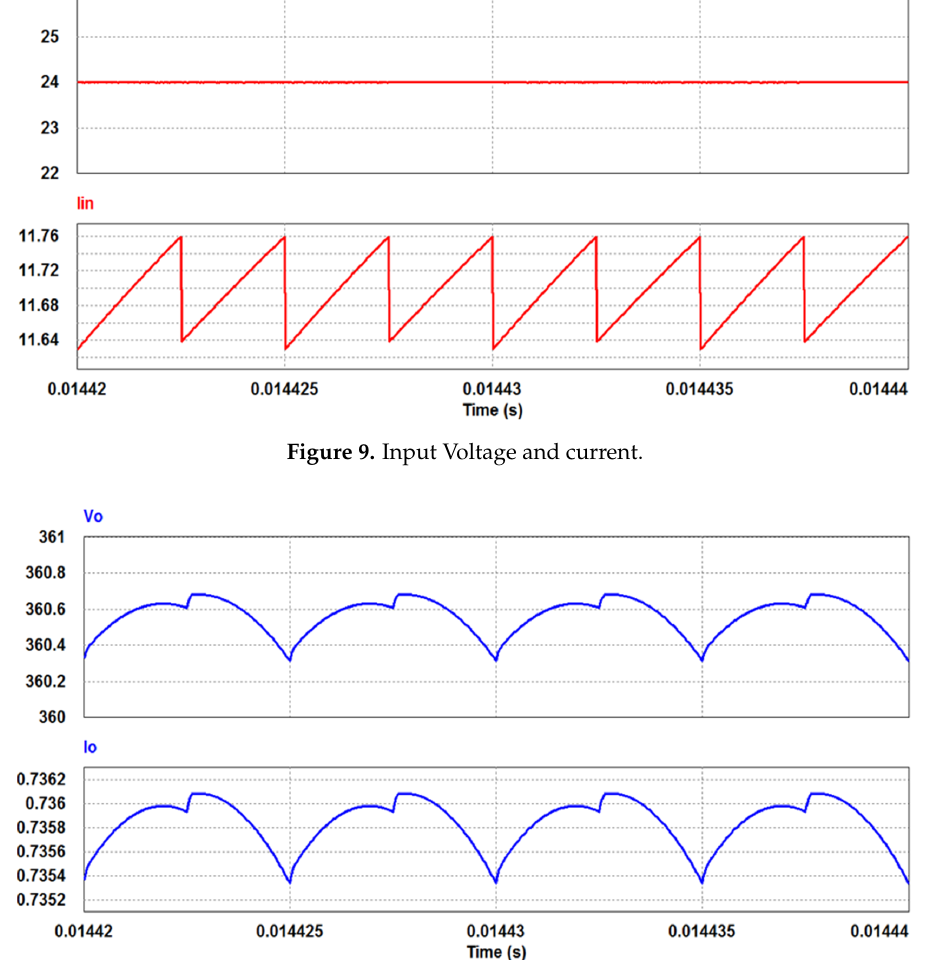
Figure 10. Output Voltage and Current.